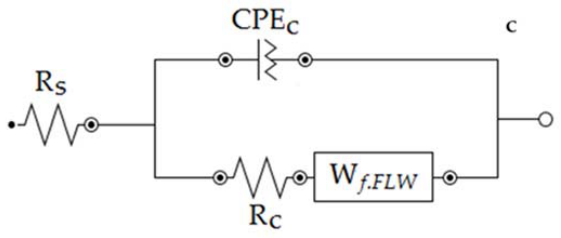
Figure 11. Nyquist plots of the neat ( a ) and ZHS-containing ( b ) epoxy coatings along with the appropriate equivalent circuit ( c ).